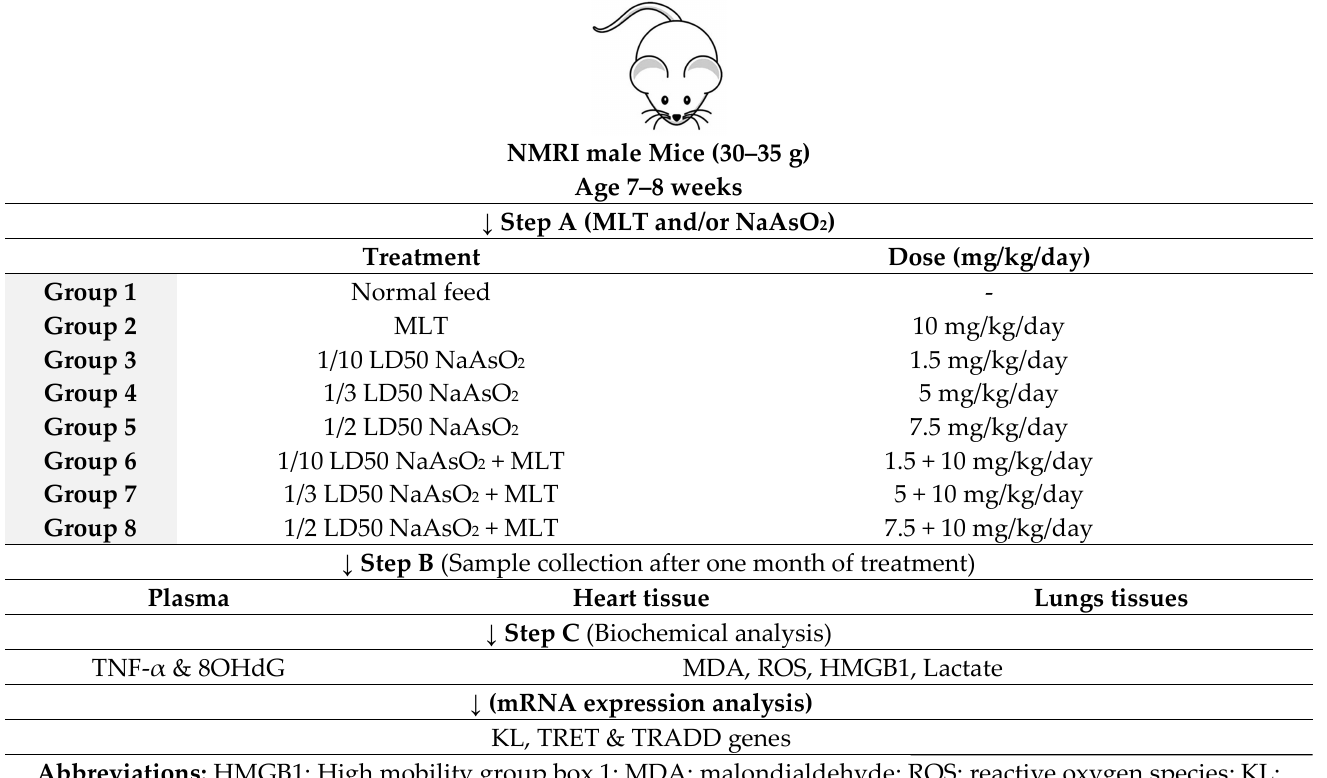
Figure 6. Study design .